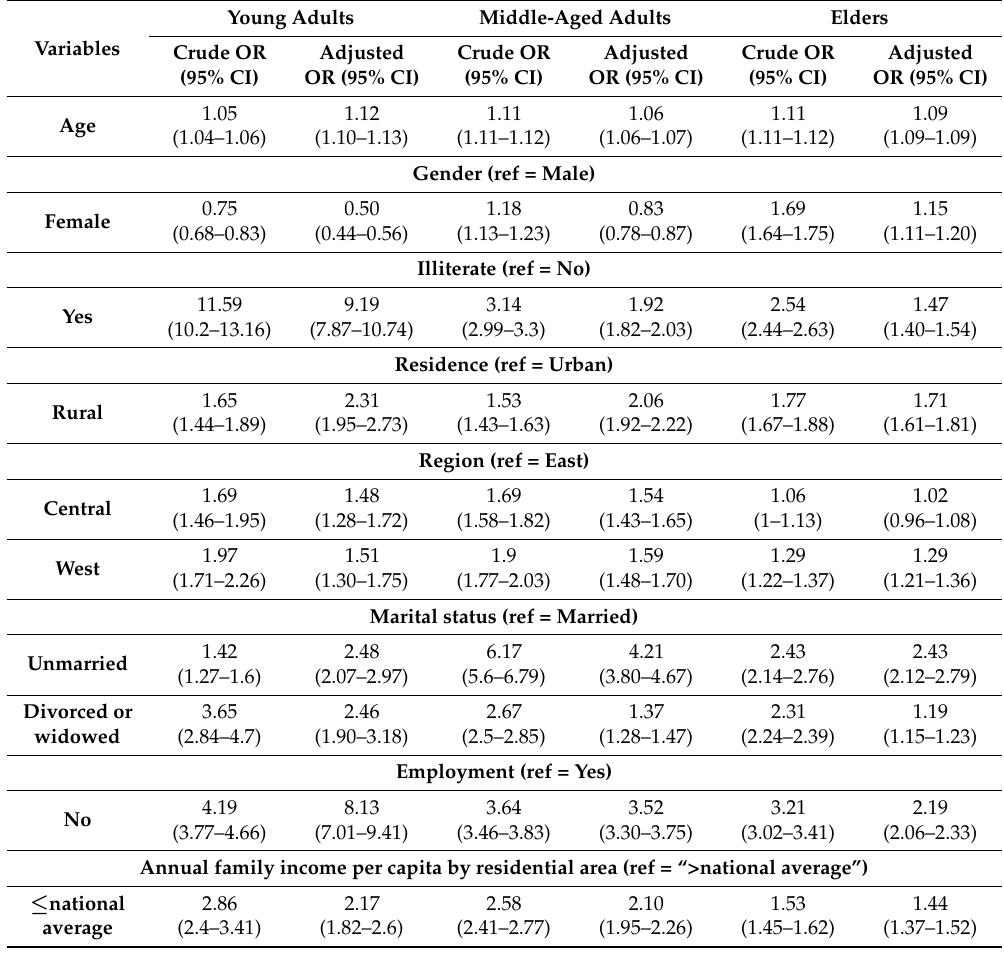
Table 4. The social factors associated with visual impairment among Chinese